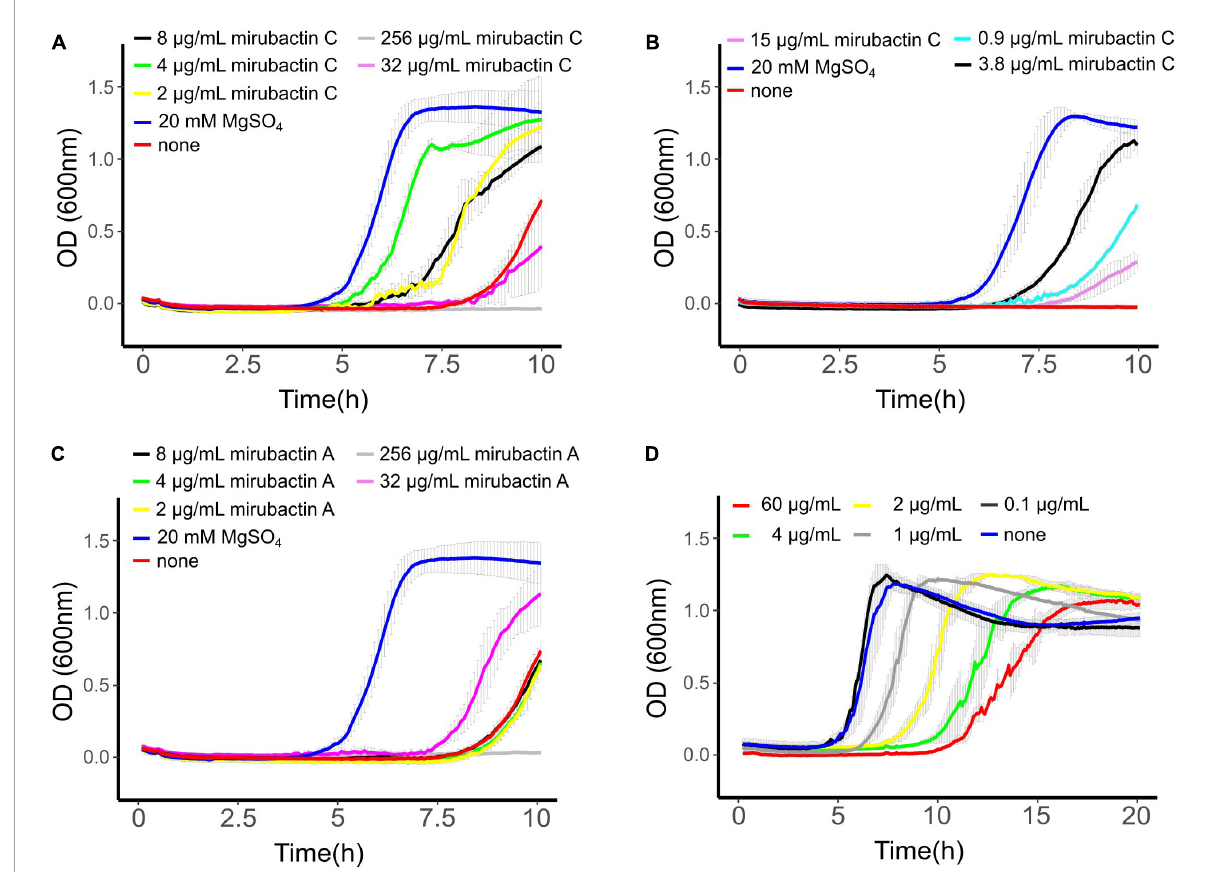
FIGURE3 (A) mbl -recovery assay with mirubactin C (256 µ g/ml gray, 32 µ g/ml magenta, 8 µ g/ml black, 4 µ g/ml green, 2 µ g/ml yellow) 20 mM MgSO 4 (blue), no addition (red). (B) mbl -recovery assay with chemically synthesized mirubactin C (15 µ g/ml purple, 3.8 µ g/ml black, 0.9 µ g/ml turquoise), no addition (red), 20 mM MgSO 4 (blue) (C) mbl -recovery assay with mirubactin A (256 µ g/ml gray, 32 µ g/ml magenta, 8 µ g/ml black, 4 µ g/ml green, 2 µ g/ml yellow), 20 mM MgSO 4 (blue), no addition (red). (D) Activity of purified mirubactin C against Bacillus subtilis 168CA,